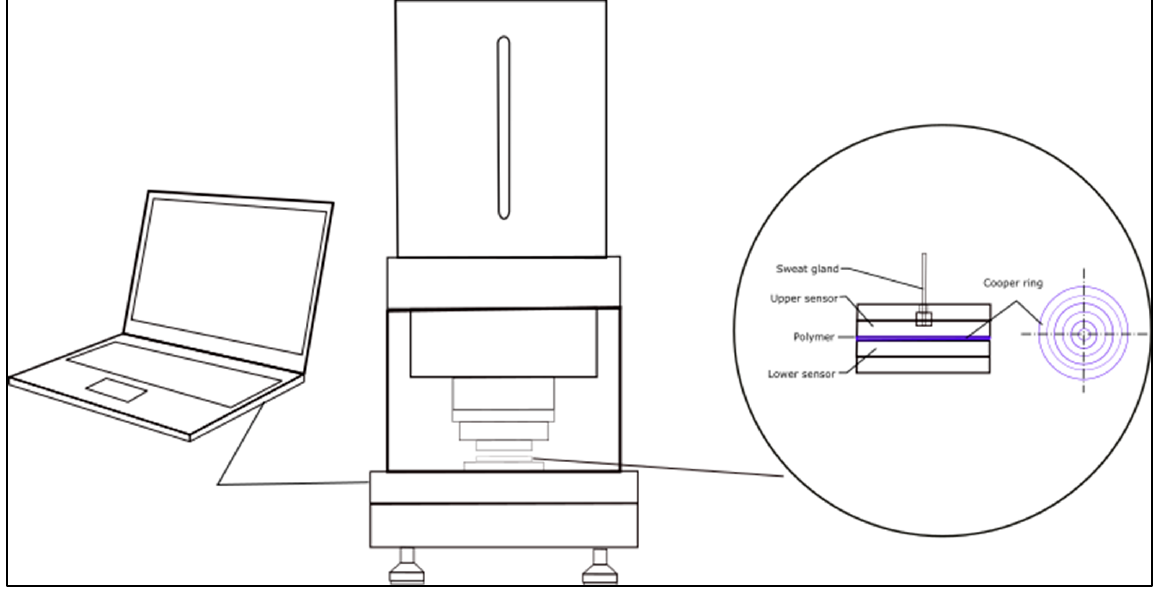
Figure 3. Moisture management measurement.